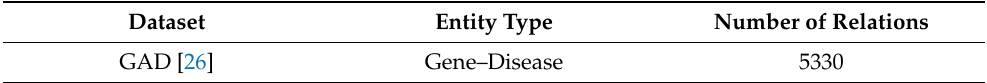
Table 4. Statistics of RE